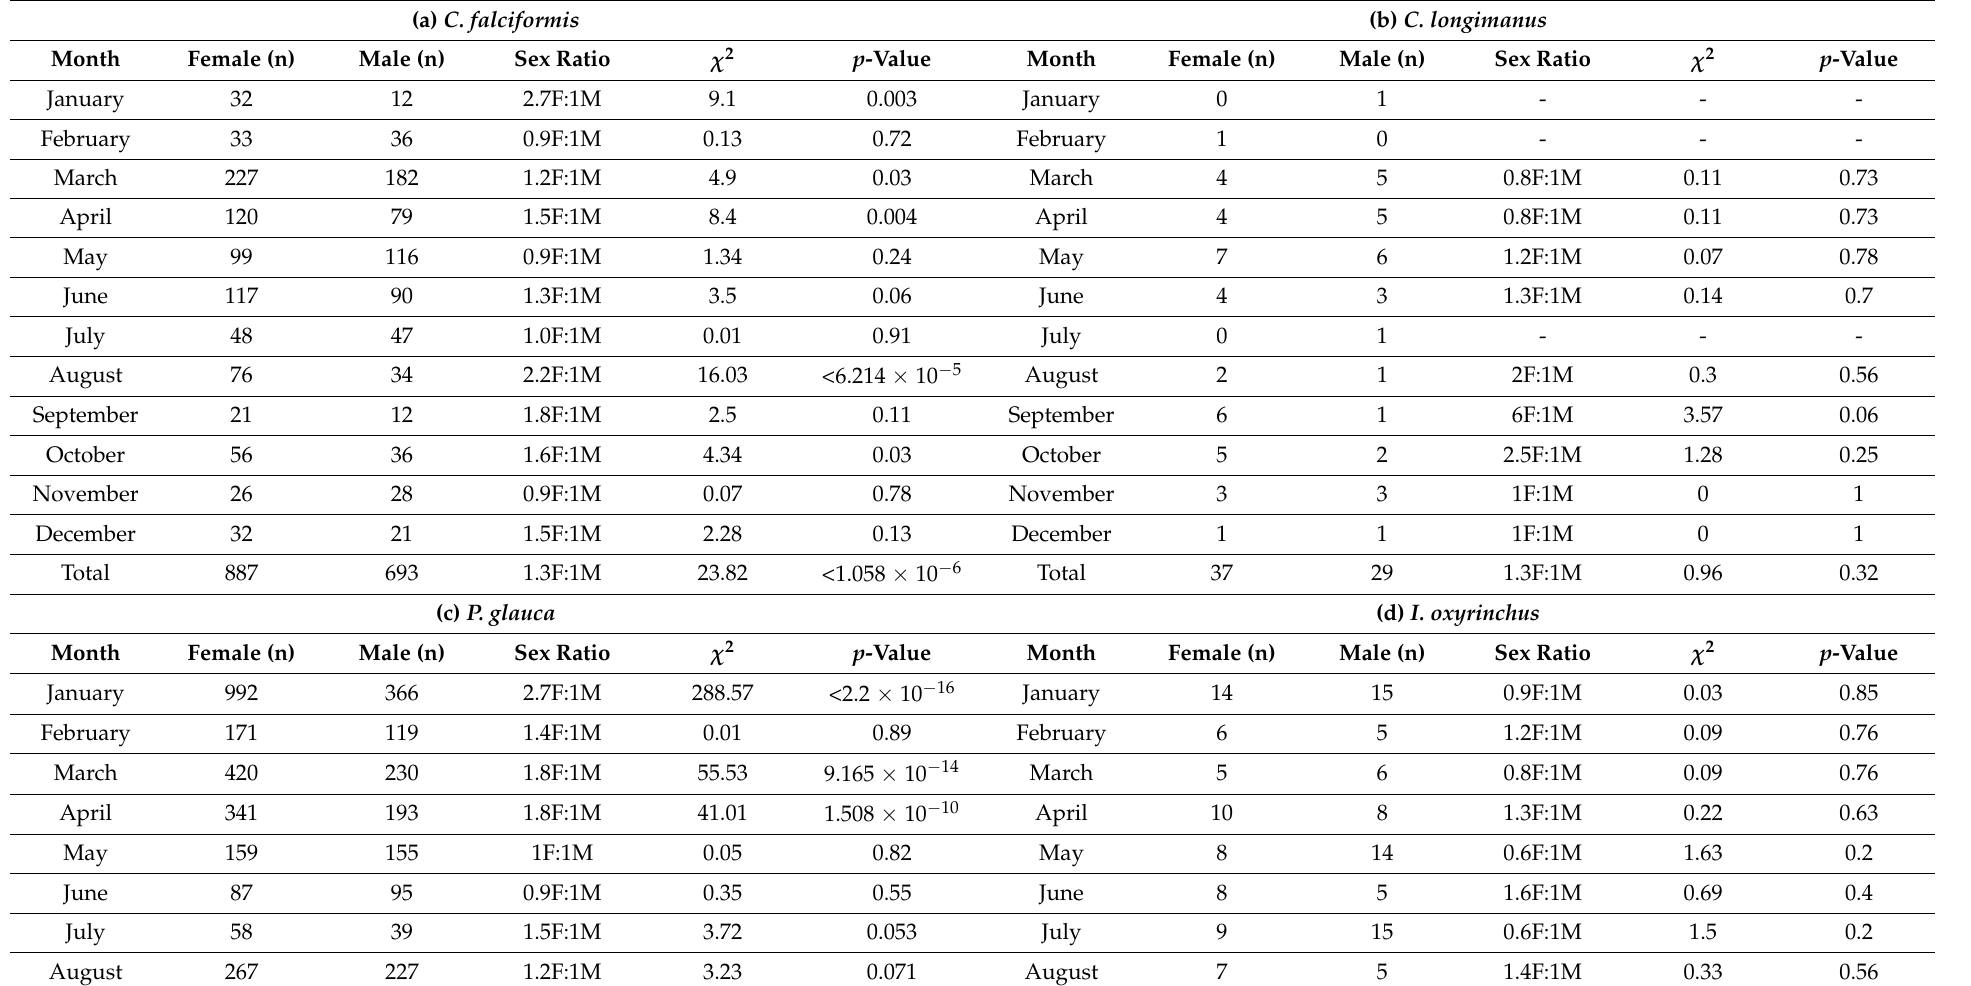
Table 4. Monthly sex ratios of the main species landed in the Ecuadorian